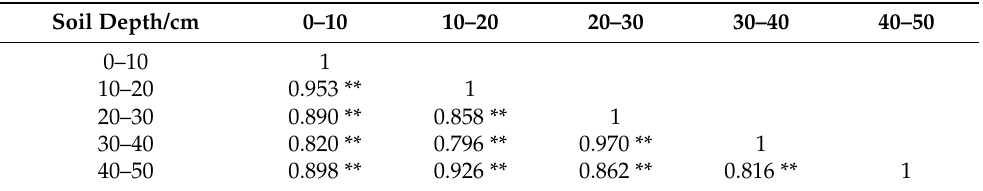
Table 4. Correlation matrix of soil moisture at different layers.